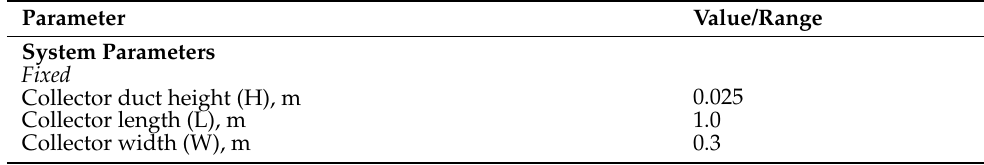
Table 1. Value/range of system and operating